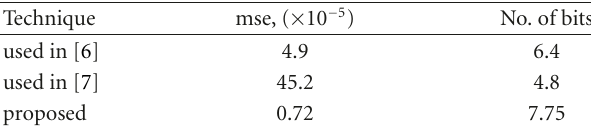
Table 2: Comparison among bitstream adders. Technique